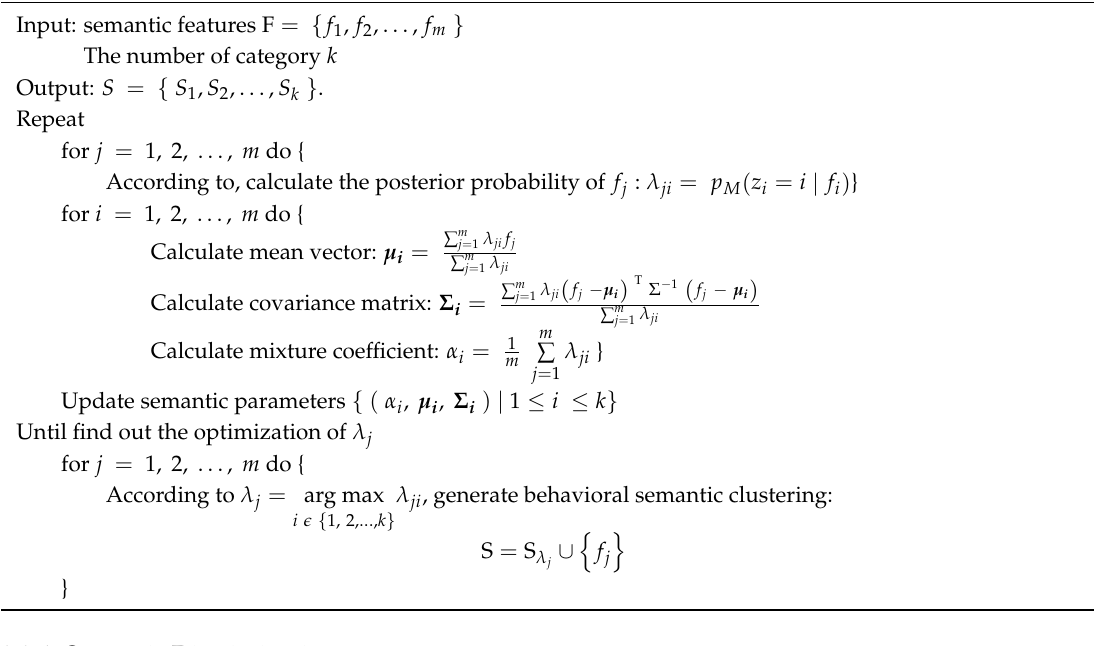
Algorithm 1. The processing of generating behavioral semantic